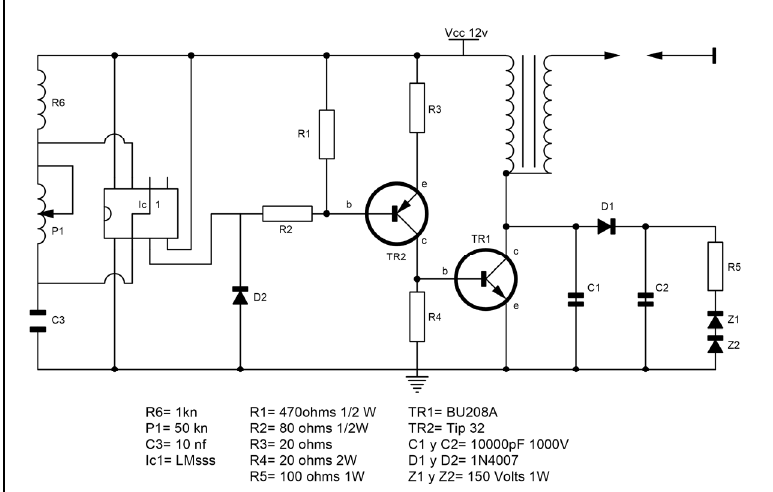
Figure 11. Electronic diagram of the power supply design.